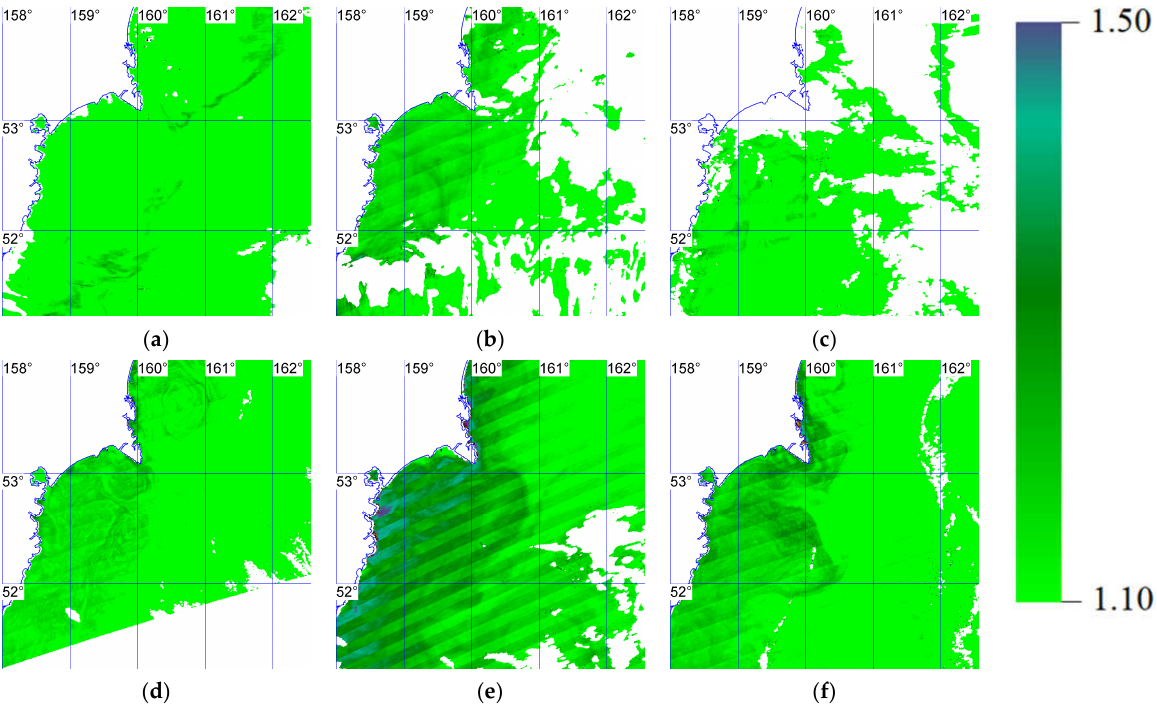
Figure 4. The variability of the F 488 parameter in Avacha Bay for the following dates: ( a )